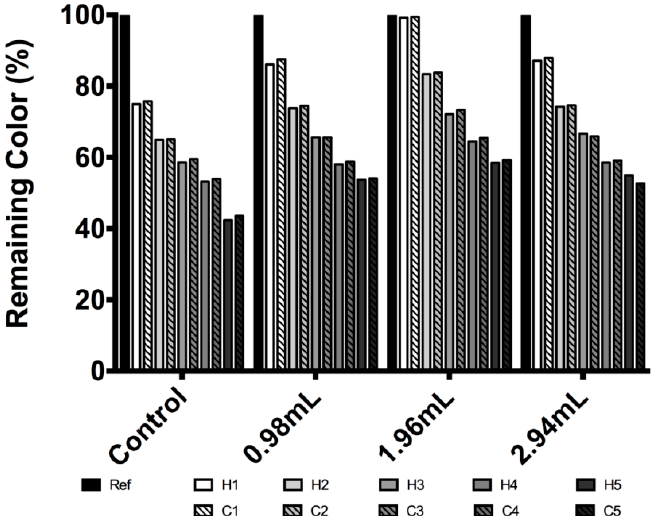
Figure 3. Betacyanin concentration expressed in remaining color percentage for temperature stability evaluation for Beta vulgaris and modified Beta vulgaris